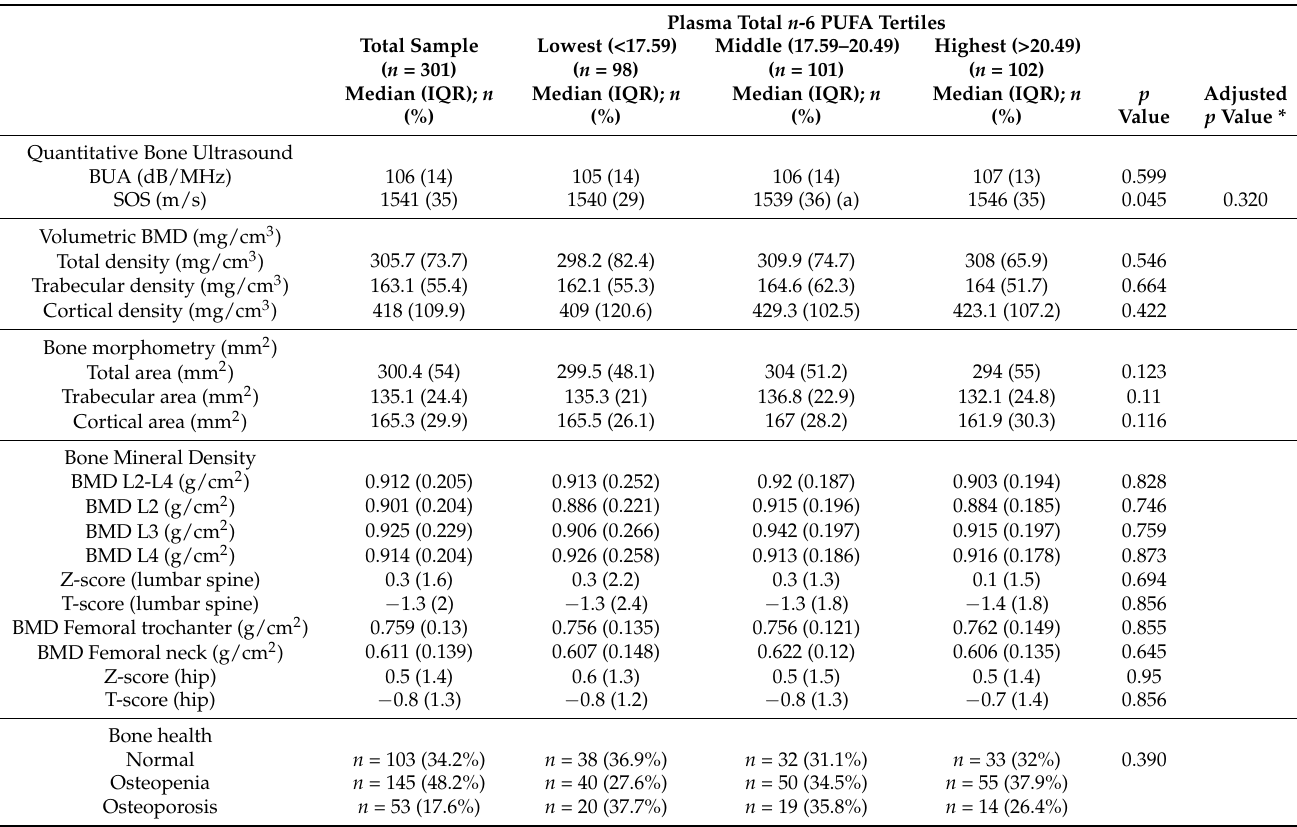
Table 4. Bone parameters by tertile of plasma n -6 PUFA (C18:2 (n6) Linoleic acid (LA) + C20:4 (n6) Arachidonic acid